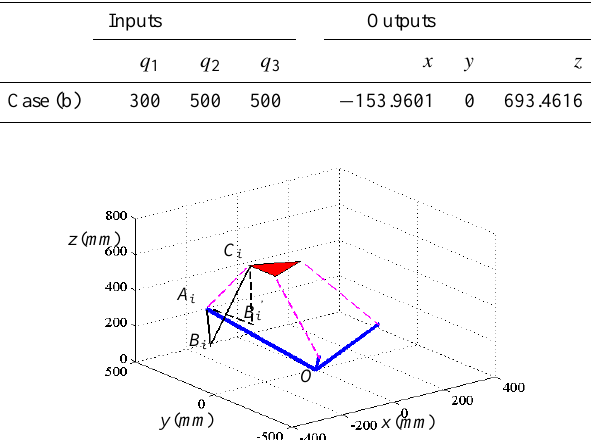
Figure 8. Different configurations for forward position analysis.